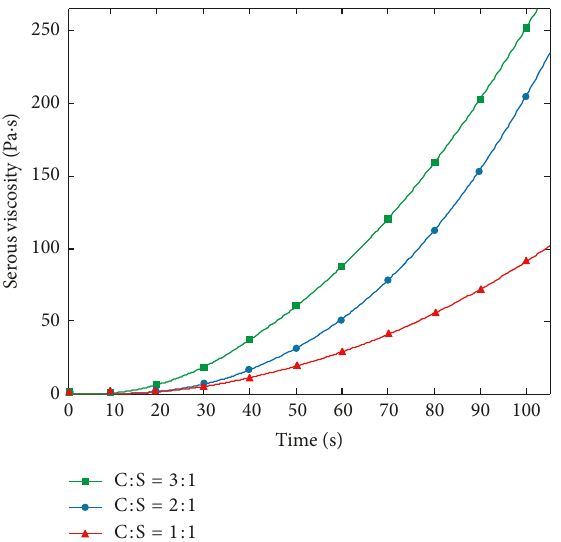
Figure 6: C-S slurry viscosity versus time.